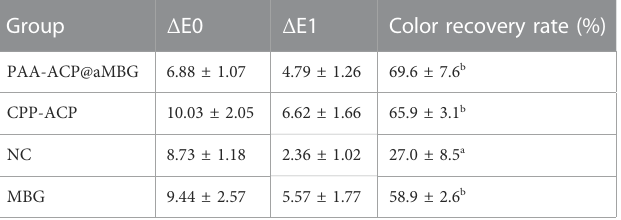
TABLE 3 Absolute values of color changes (mean ± SD) and color recovery rates (mean ± SD, %) for the four groups ( n = 10). Group Δ E0 Color recovery rate